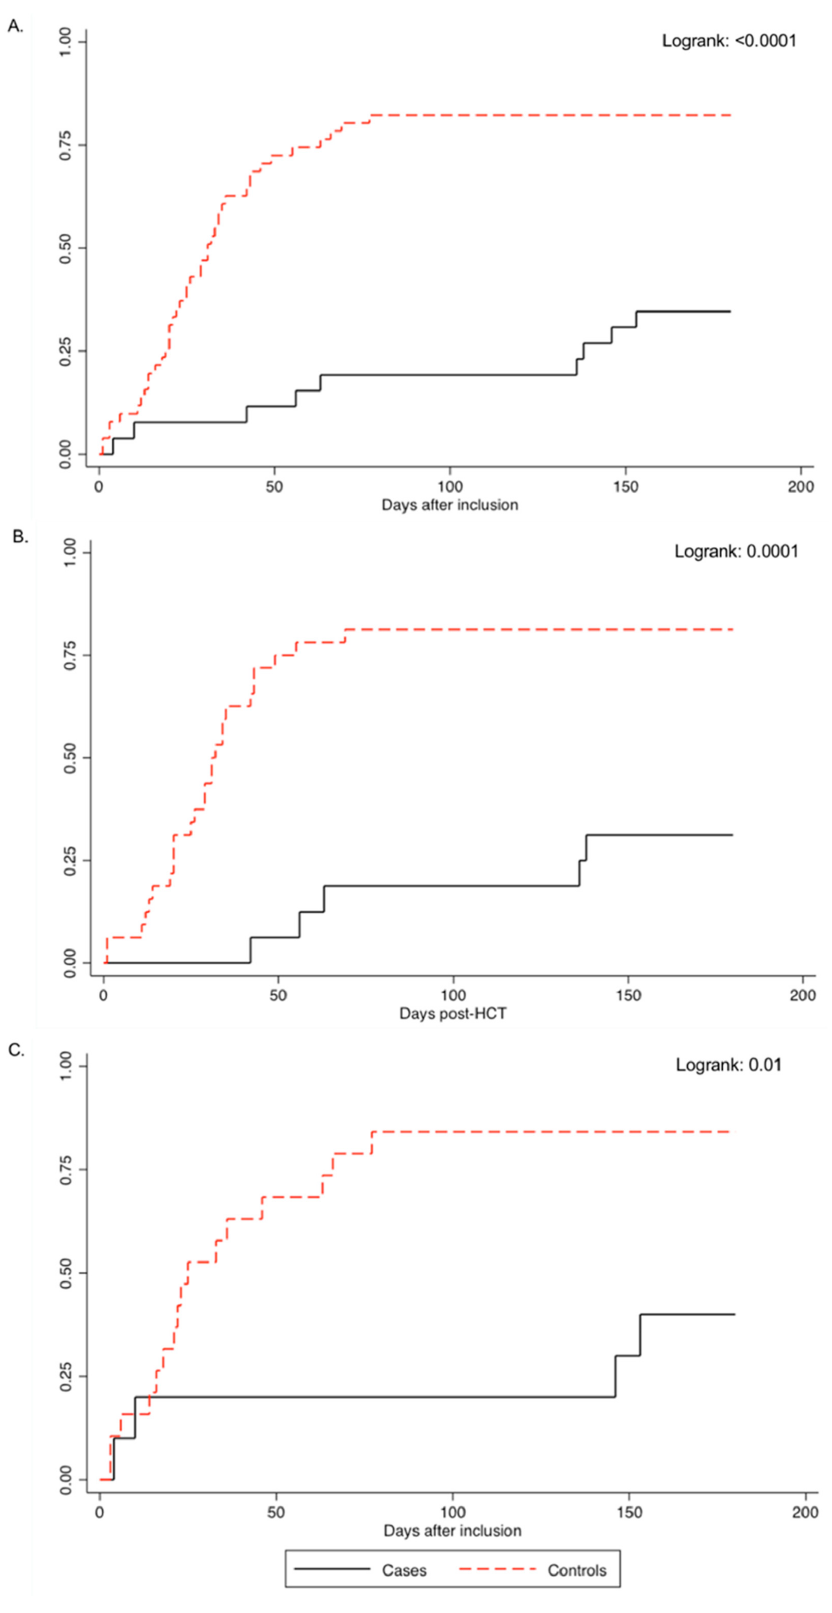
Figure 1. Cumulative incidence of clinically significant CMV infection between cases (black line) and controls (red line) in the ( A ) overall patient population, ( B ) CMV donor negative/recipient positive group, and ( C ) CMV recipient positive with graft versus host disease group. Thirty-four patients developed more than one csCMV infection: three in cases (11.5%) and 31 in controls (59.6%, p -value < 0.0001). Six patients developed CMV biopsy-proven end-organ disease: 1 (3.8%) in cases and 5 (9.6%) in controls ( p -value: 0.66), involving the central nervous system (three patients), gastrointestinal tract (one patient), and liver (two patients). Risk factors associated with development of csCMV infection were analyzed in uni- variable and multivariate regression models (Table 3). The absence of letermovir prophy- laxis in controls was the only and strongest predictor of csCMV infection (OR: 9.14, 95%CI 2.94, 28.3, p -value < 0.0001). Table 3. Risk factors analysis for clinically significant CMV infection. Variables